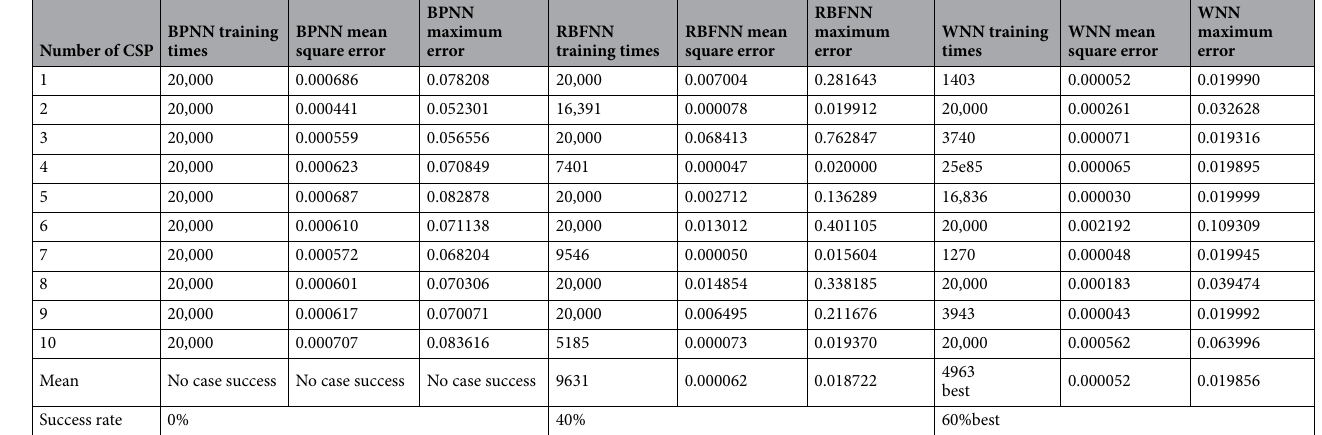
Table 2. Simulation results of "Hyperparameter optimization experiment ".